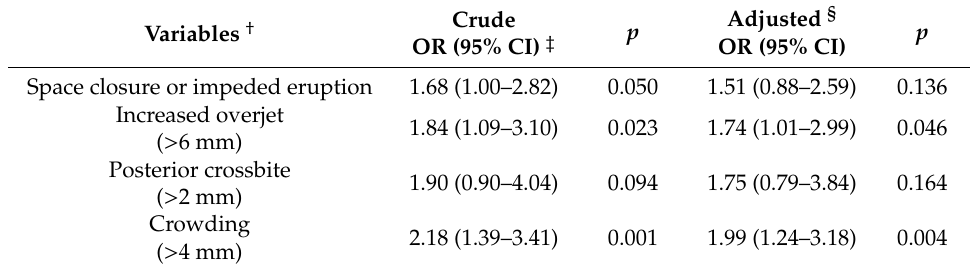
Table 4. Logistic regression model for the association between poor oral hygiene * and the types of occlusal anomalies with the Normative Need for Orthodontic Treatment (NNOT)